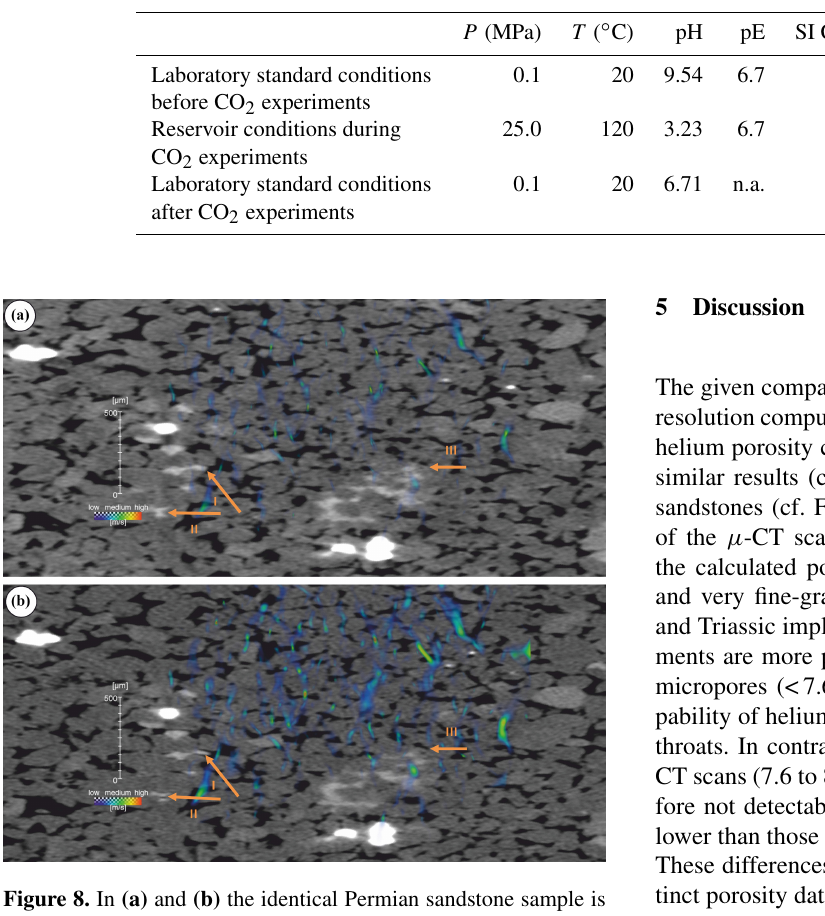
Table 4. PHREEQC modelling, showing saturation results of the interaction of the synthetic formation fluid used before, during and after the CO 2 experiments exposed to the Permian sandstones (n.a. is not analysed, SI is the saturation index, p E is the negative logarithm of electron concentration directly proportional to the redox potential).